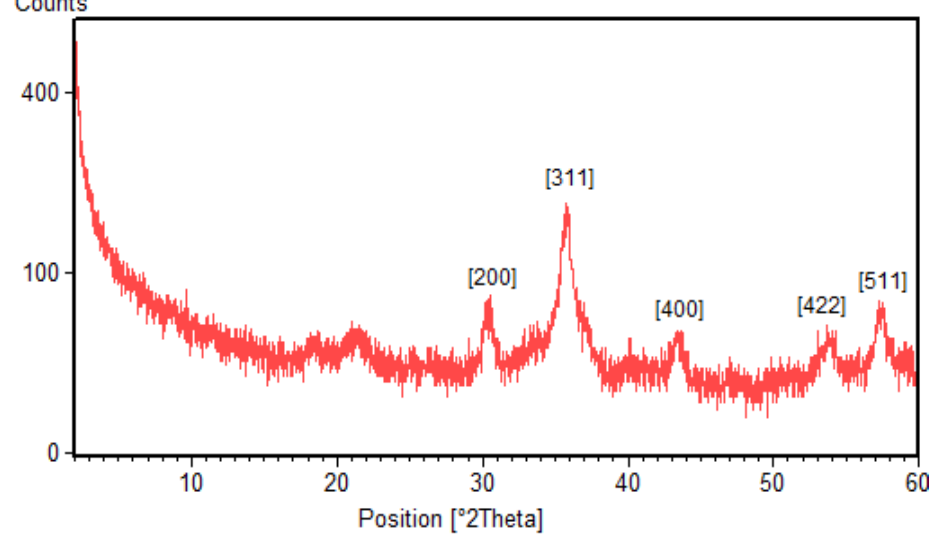
O -NPs synthesized using BS 3 4